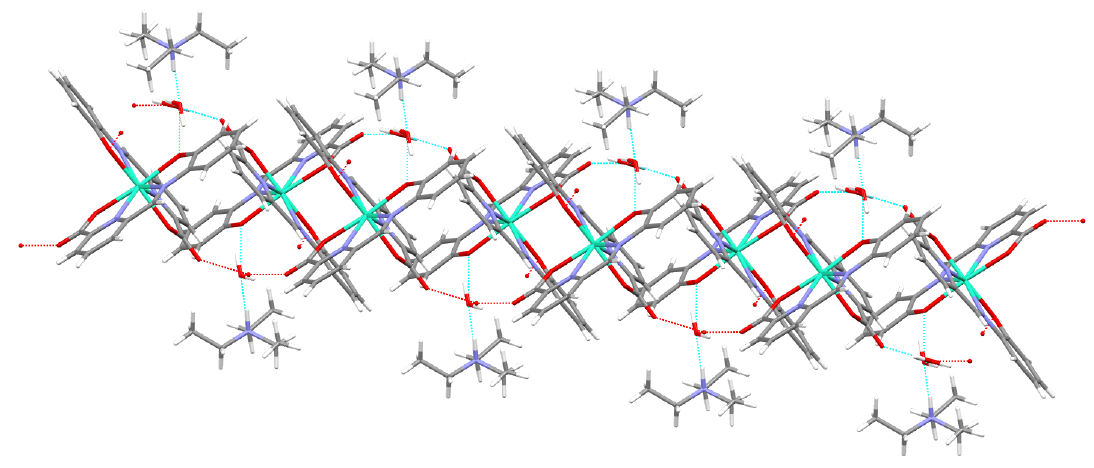
Figure 2. Hydrogen bond scheme among the 1a units, involving the Et 3 NH + cations and water solvate.